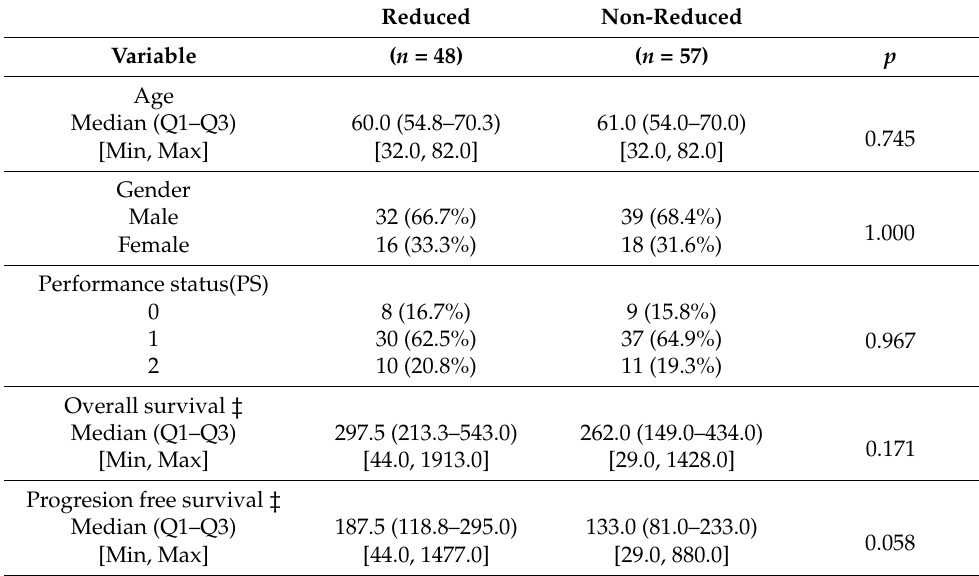
Figure 2. Overall survival according to the PLT-count in the high (PLT < 400 × 10³/µL) vs low (PLT > 400 × 10³/µL) groups. Baseline patient demographic and clinical characteristics across reduced platelets (PLT-red < 60%) and non-reduced platelets (PLT-red 60%) patients are shown in Table 1. Table 1. Baseline characteristics.